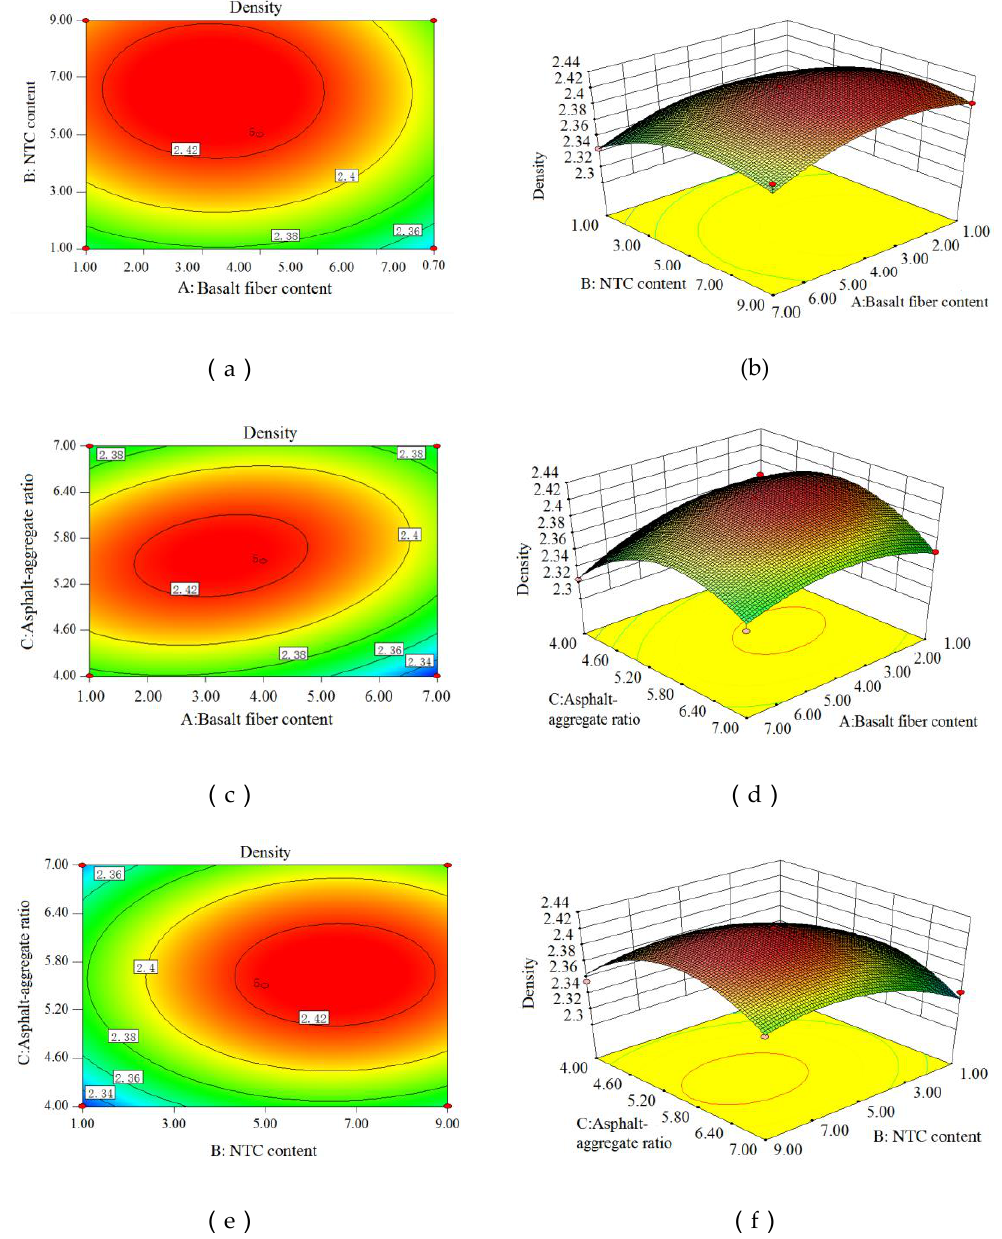
Figure 4. Contour map and response surface map of density and influencing factors. ( a ) Contour map between basalt fiber content, NTC content and density; ( b ) Three-dimensional surface graph between basalt fiber content, NTC content and density: ( c ) Contour map between basalt fiber content, asphalt–aggregate ratio and density; ( d ) Three-dimensional surface graph between basalt fiber content, asphalt–aggregate ratio and density; ( e ) Contour map between asphalt–aggregate ratio, NTC content and density; ( f ) Three-dimensional surface graph between asphalt–aggregate ratio, NTC content and density.